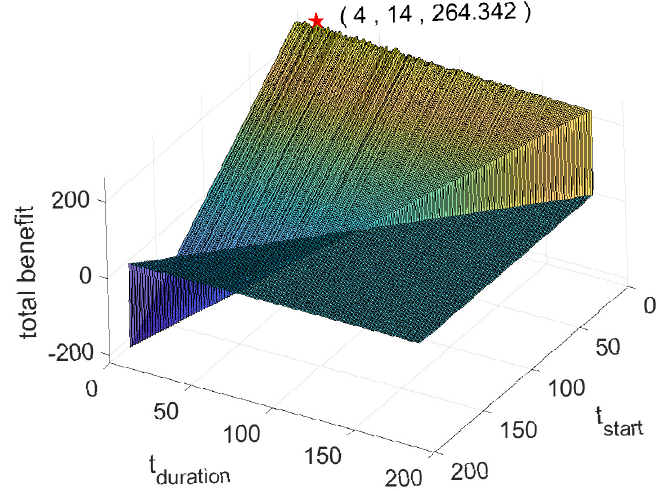
Figure 1. The results of the reassignment